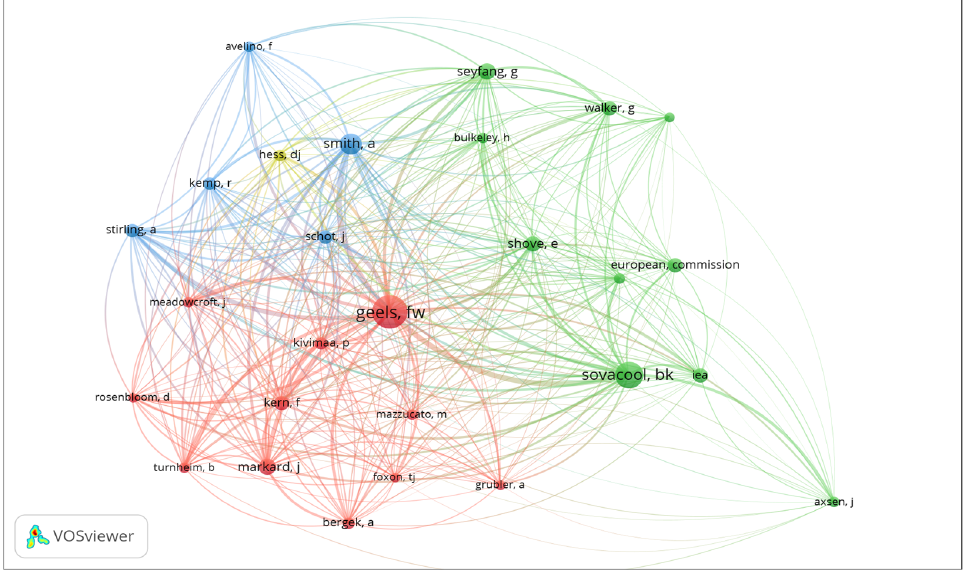
Figure 4. VOSviewer diagram containing the most cited authors with a minimum of 60 citations, for the couple: social innovation–energy transition.